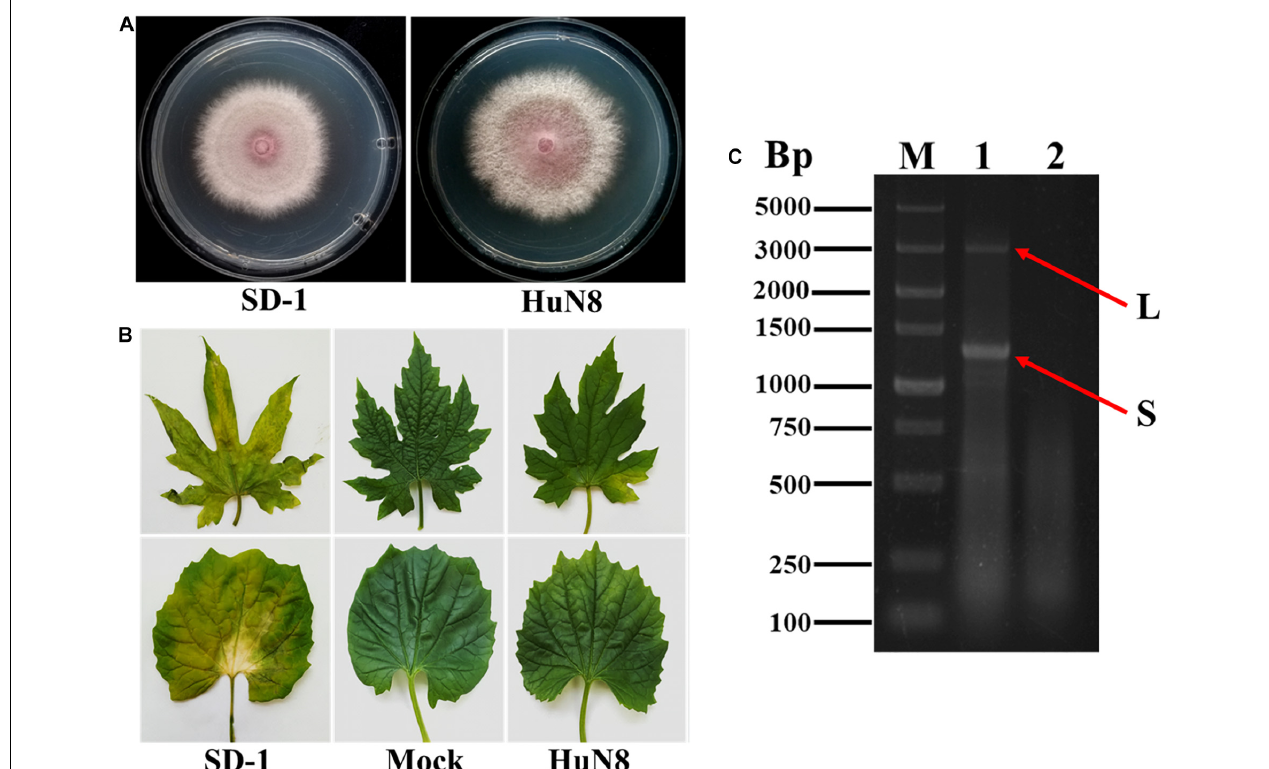
FIGURE 1 | The biological characteristics and dsRNA pattern of Fusarium oxysporum f. sp. momordicae strain HuN8. (A) Colony morphology of strain HuN8 and virulent strain SD-1 (cultured on PDA for 2 days at 28 ◦ C). (B) Pathogenicity of strain HuN8 and SD-1 on the detached bitter gourd leaves (72 h post-inoculation at 28 ◦ C). Mock, blank control. (C) Agarose gel electrophoretic analysis of the dsRNA extracted from strain HuN8. The dsRNA was treated with DNase I. M, molecular weight marker; 1, dsRNA extracted from strain HuN8; and 2, dsRNA extracted from strain